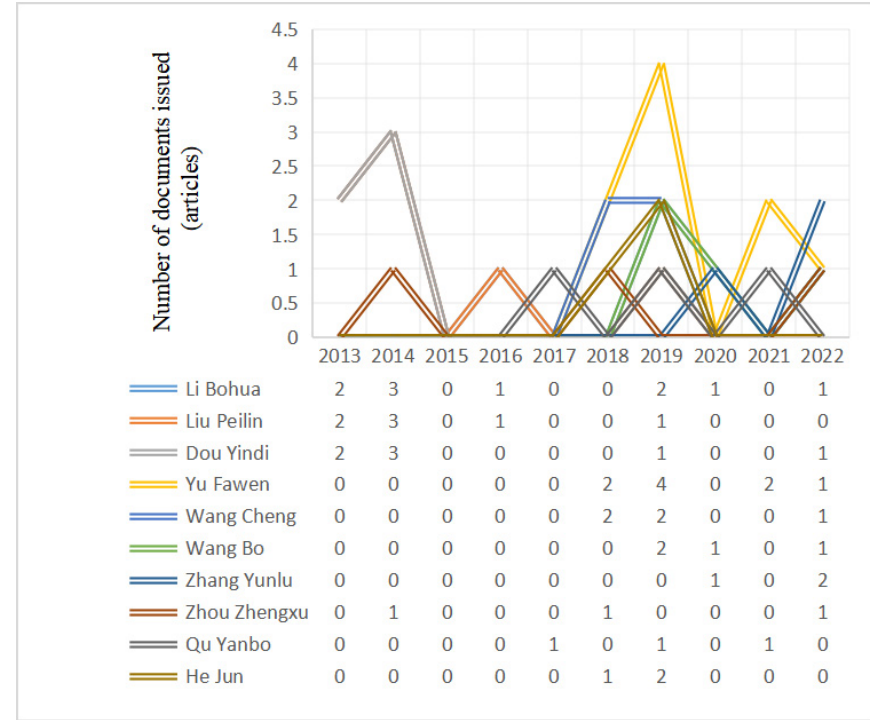
Figure 4. Author publication trends for rural human settlement environment research.